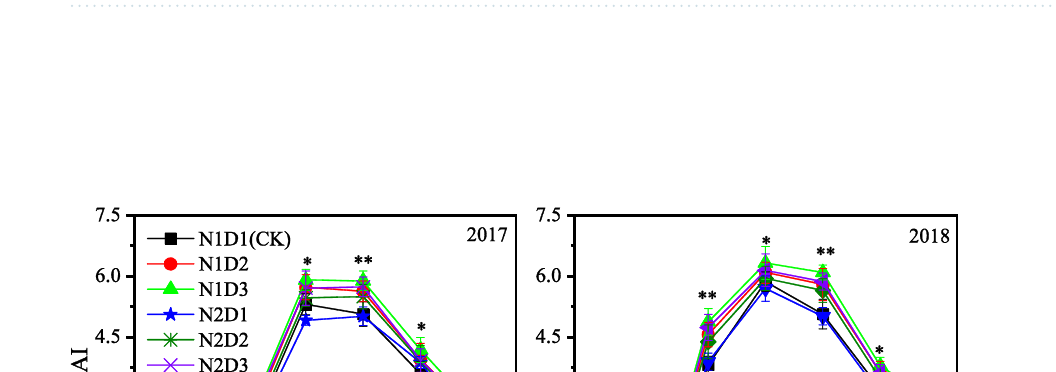
Figure 1. N uptake, N harvest index and N partial factor productivity of maize (NPFP) under different planting treatments in 2017 and 2018. Error bars indicate standard errors of replicates. Means followed by the same letter are not significantly different among different planting treatments at P < 0.05.